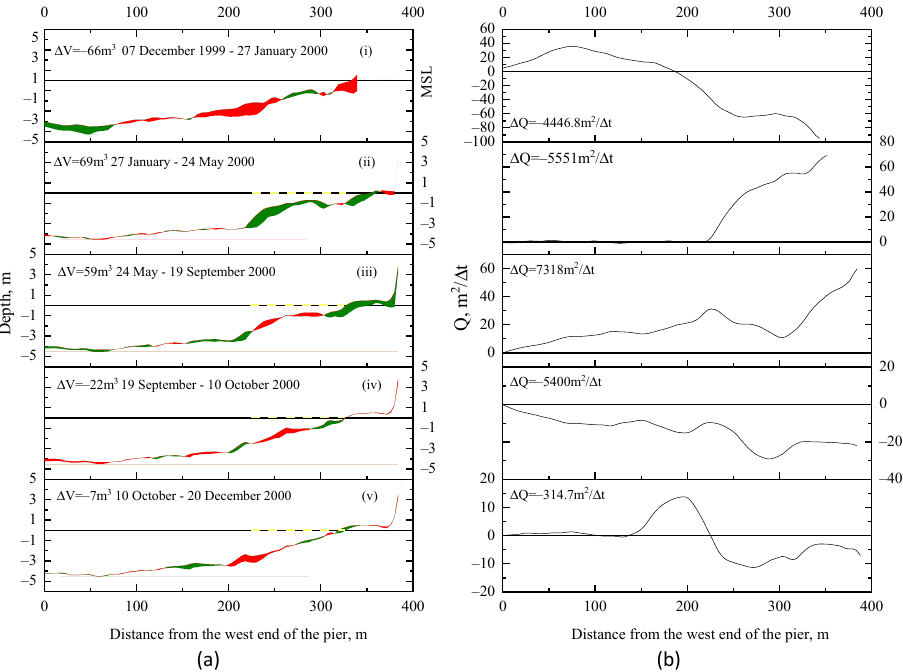
Figure 6. ( a ) Cross-shore profile changes (green-sand accumulation, red-sand loss) and ( b ) sediment transport rate Q, ( i ) December 1999–January2000, (ii) January–May2000, ( iii ) May–Septem- ber 2000, ( iv ) September–October 2000, ( v ) October–December 2000.